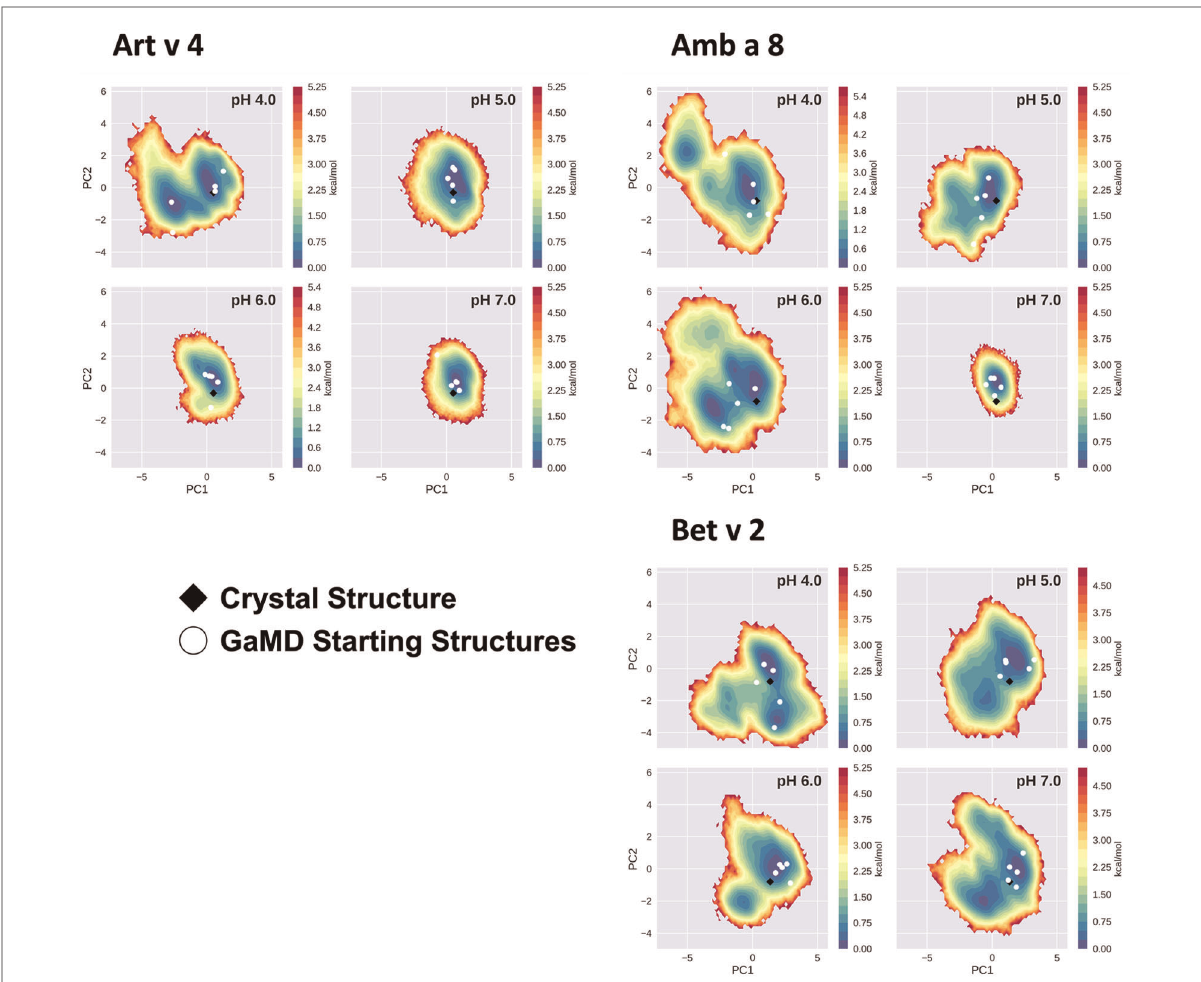
FIGURE 3 Free energy landscape explored by each allergen. The structural data accumulated for each pro fi lin is projected onto a combined PCA plot to visualize the explored conformational space at each individual pH value. Crystal structures of each system are shown in black diamonds and the GaMD starting structures are depicted as white